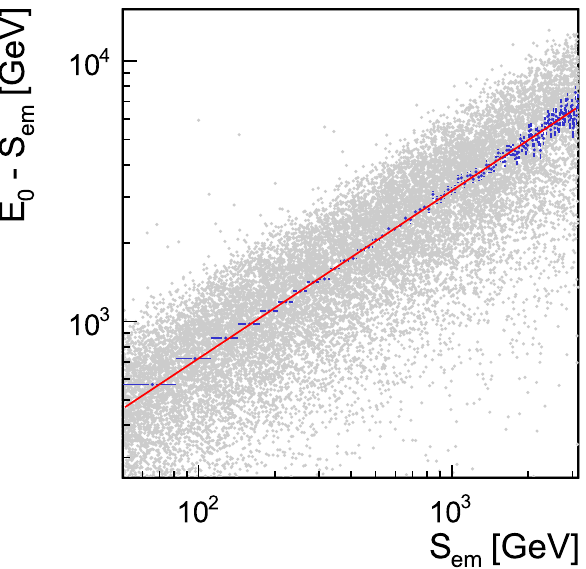
Fig. 10 Correlationoftheenergydepositedintheatmosphere(primary energy minus the electromagnetic energy at the ground), E 0 − S em with the energy deposited at the ground S em . The line corresponds to the best parametrization (see text for